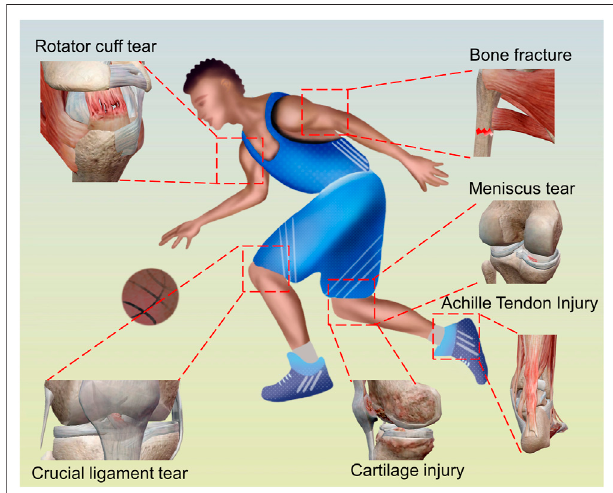
FIGURE 1 | Sports medicine related